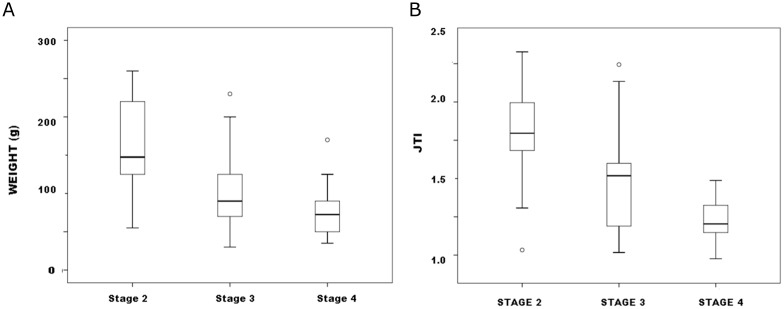
Callahan Stage 2–4 preforms boxplots by stage: a. weight; b. JTI.